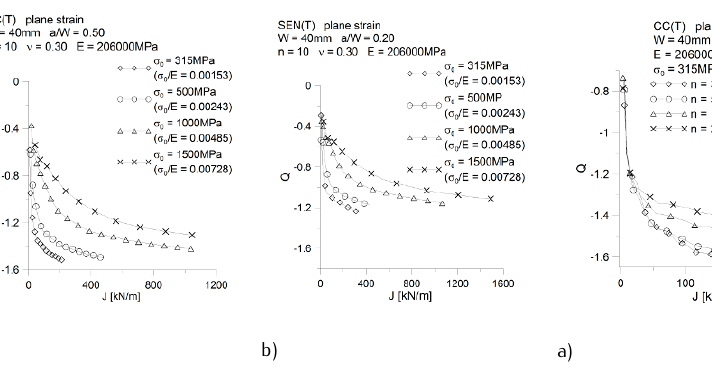
Figure 10. The influence of the work-hardening exponent on J - Q (a) and Q =f(log( J /( a ·σ 0 ))) (b) trajectories for CC(T): a / W =0.20, σ 0 =315 MPa (plane strain for distance from crack tip r =2.0 · J / σ 0